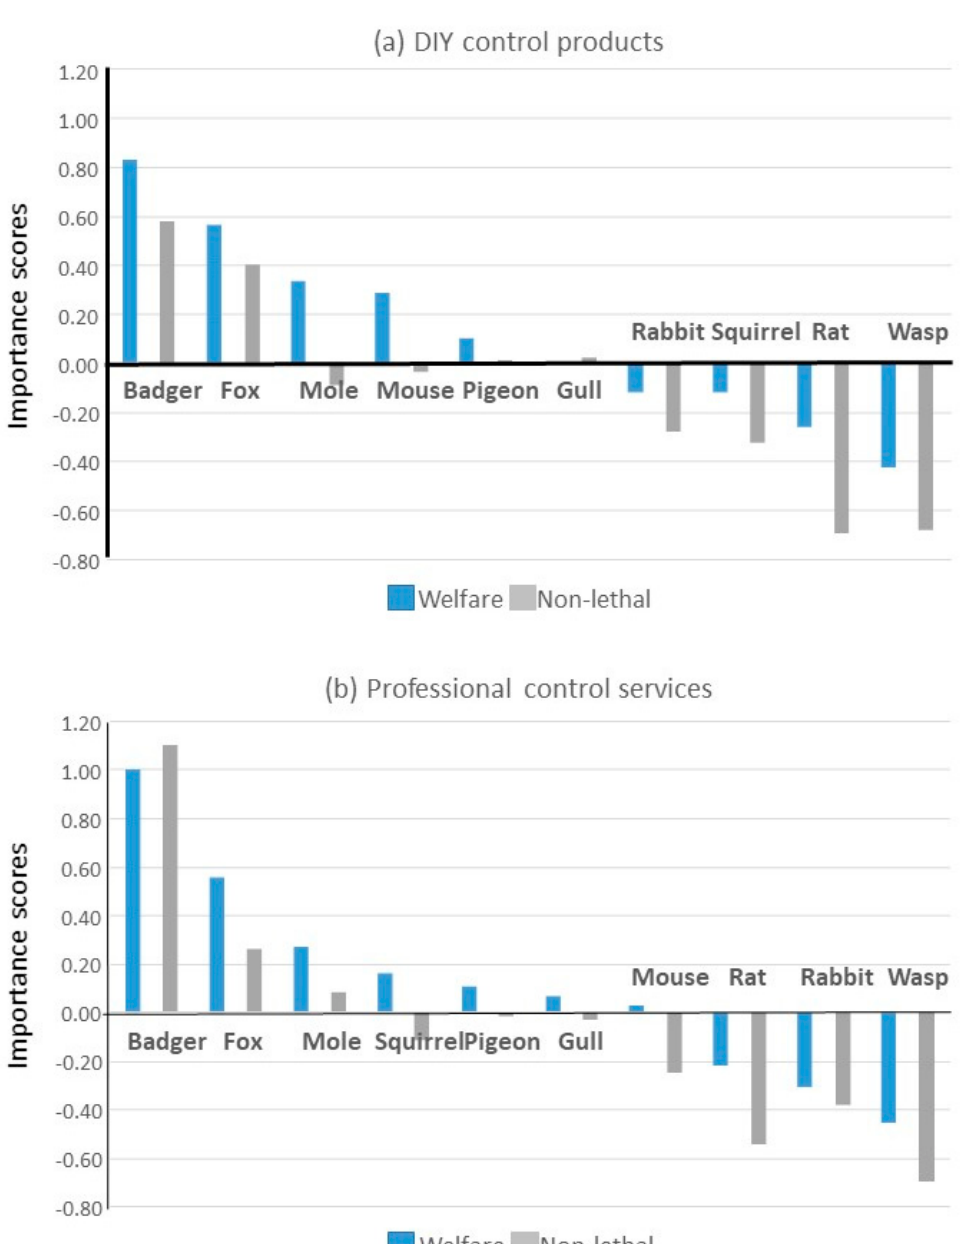
Figure 7. The importance of welfare-friendliness and non-lethality in choosing: ( a ) DIY pest control products; or ( b ) professional pest control services ( n values as per Table 3). Positive importance scores (bars above horizontal axis) indicate that a factor is considered important in choosing control, and greater scores indicate greater importance.